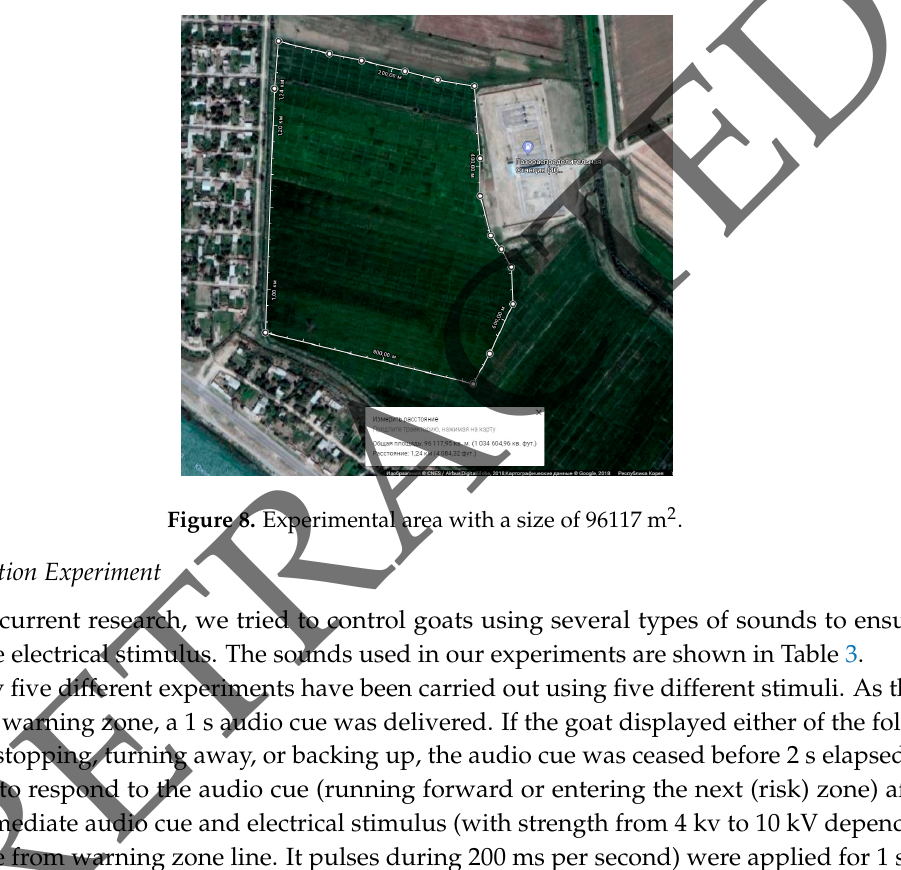
Figure 8. Experimental area with a size of 96117 m 2 .